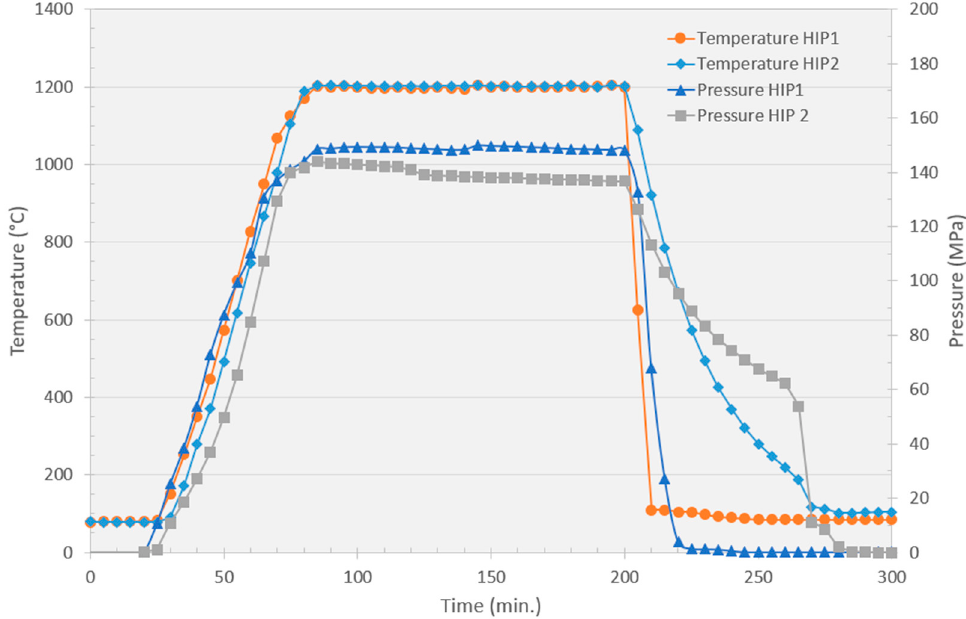
Figure 1. Temperature and pressure evolution during Hot Isostatic Pressing performed on Quintus QIH21 equipment.